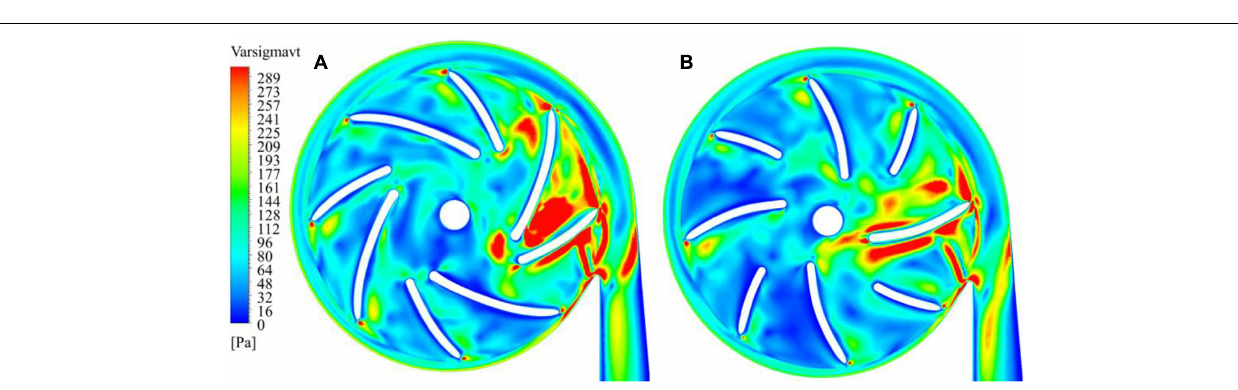
FIGURE 4 | Contours of effective stress: (A) model 1; (B) model